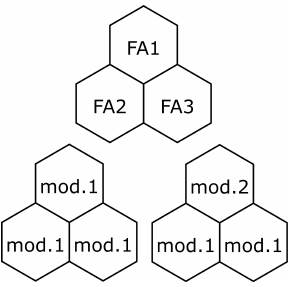
Figure 2. Three fuel assemblies calculation variants.